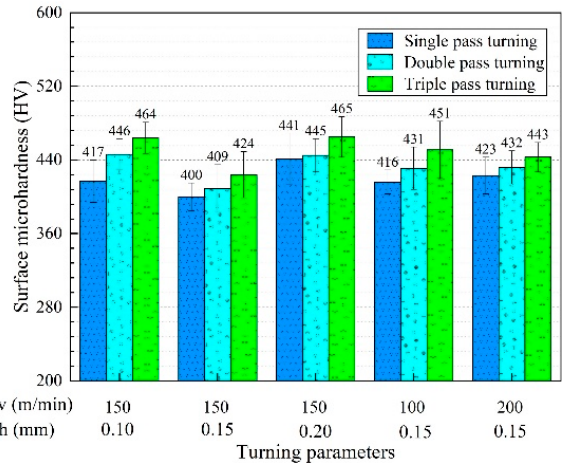
Figure 8. Surface microhardness under multi-pass turning conditions.